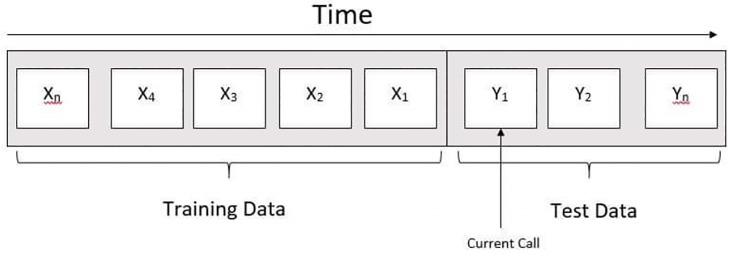
Division of user’s call log using cross validation technique.